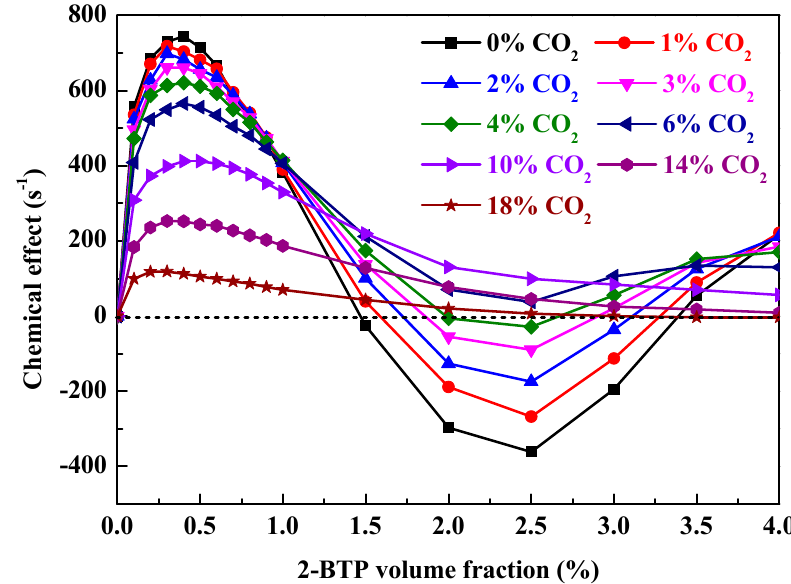
Figure 6. The dependence of chemical effect on 2-BTP volume fraction with varying CO 2 addition in Φ = 0.6 moist C 3 H 8 /air flames at 298 K and 1 bar.